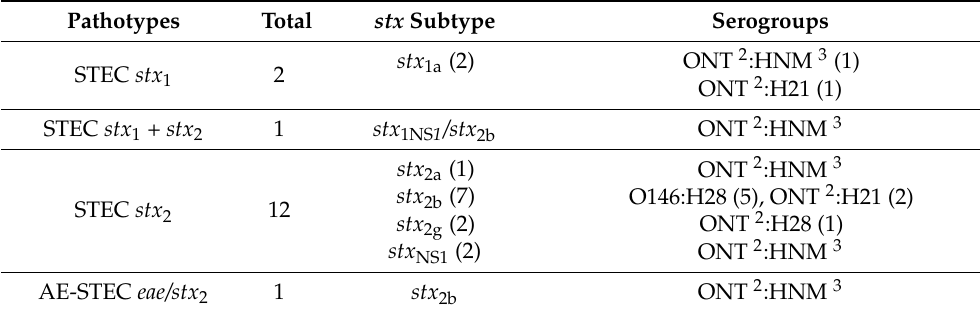
Table 2. Serotype, stx subtype, and the number of isolates harbouring virulence genes in STEC strains isolated from roe deer ( Capreolus capreolus